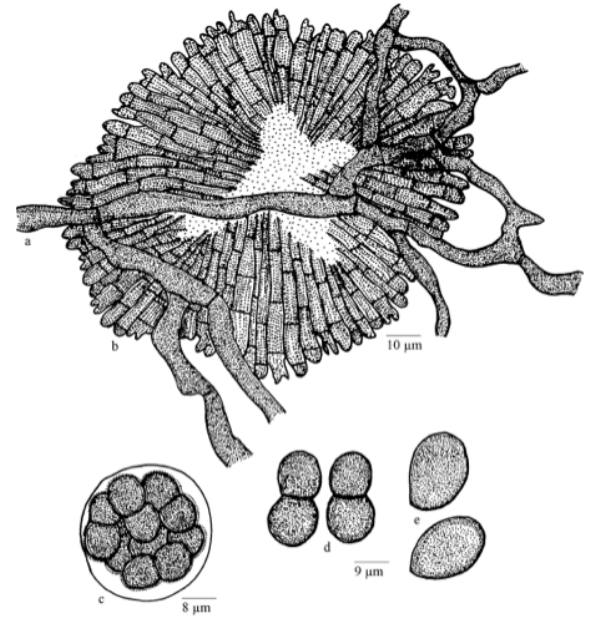
Figure 177. Prillieuxina loranthi a - Mycelium; b - Thyriothecium; c - Ascus; d -